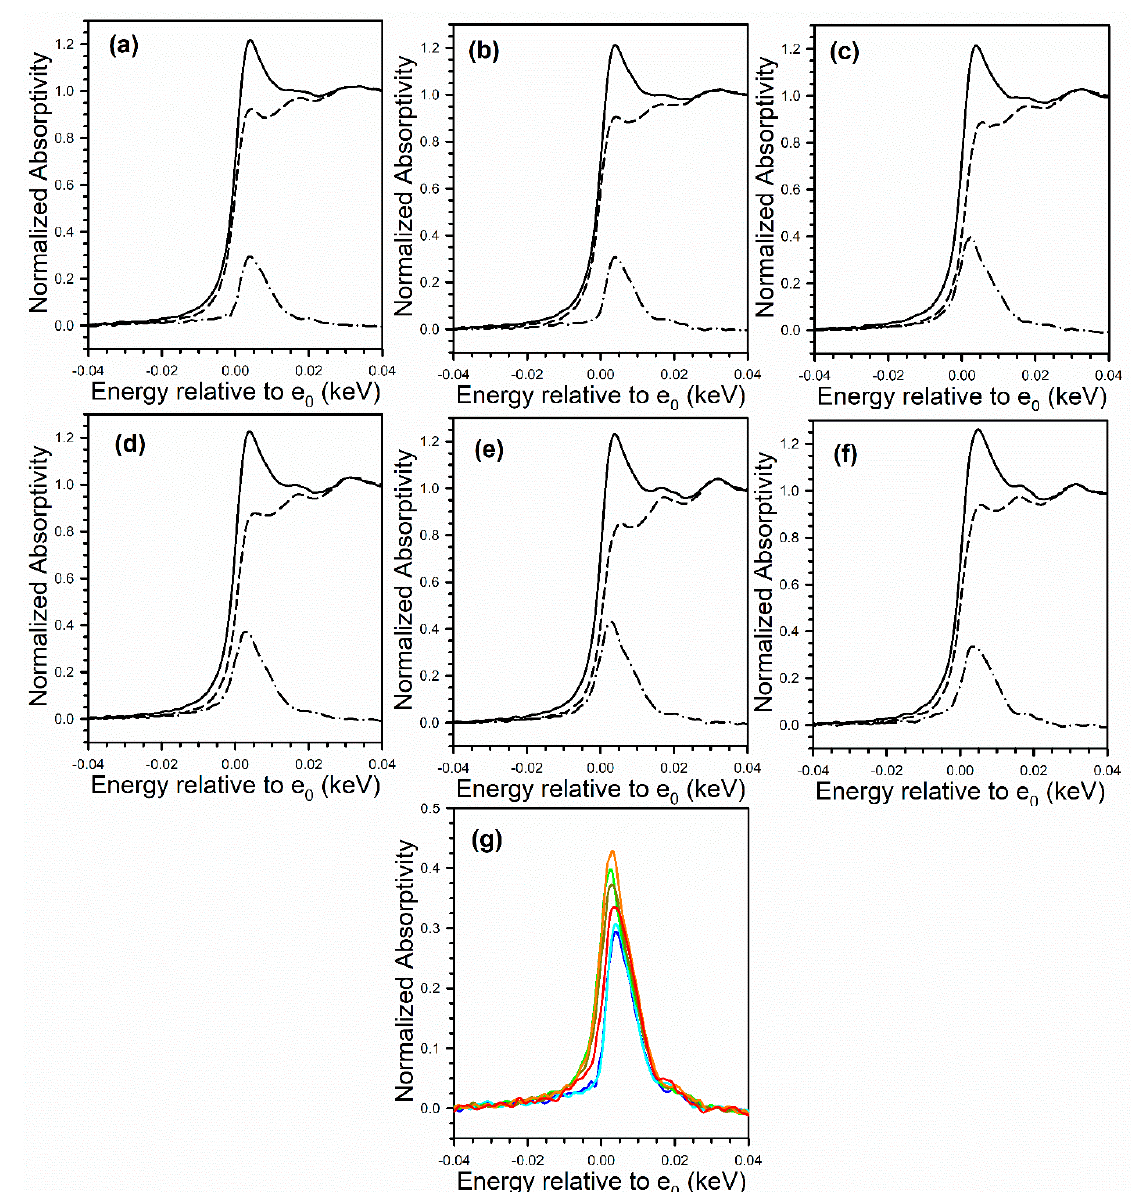
Figure 14. XANES spectra at the Pt (solid line) L 3 edge and (dashed) line L 2 edge, as well as (dash-dotted line) the L 3 –L 2 difference spectra of ( a ) 2% Pt/ZrO 2 , ( b ) 2.9% Cs-2% Pt/ZrO 2 , ( c ) 4.8% Cs-2% Pt/ZrO 2 , ( d ) 5.8% Cs-2% Pt/ZrO 2 , ( e ) 10.4% Cs-2% Pt/ZrO 2 , ( f ) 14.5% Cs-2% Pt/ZrO 2 , and ( g ) overlays of L 3 –L 2 difference spectra, showing an increase in intensity with Cs loading. No evidence for e − transfer to Pt from Cs was found, which should result in an opposite trend (reprinted from [20] with permission from Catalysts, MDPI).